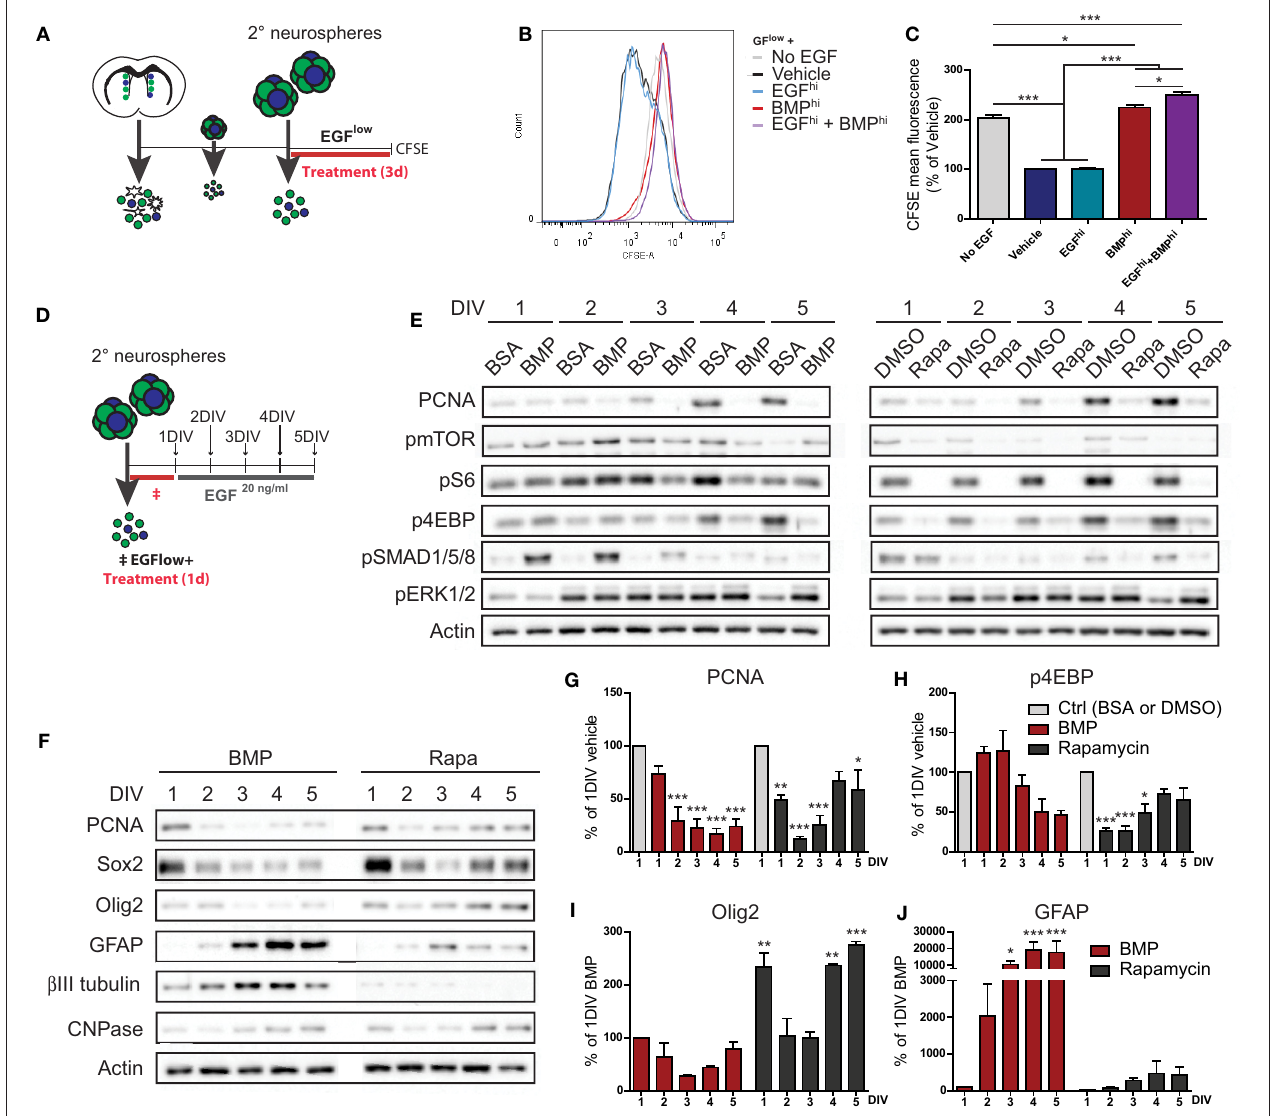
FIGURE 3 | Similarities and differences between BMP treatment and EGF withdrawal-induced suppression of TAP proliferation. (A–C) Effect of EGF and BMP on proliferation kinetics. Experimental paradigm for CFSE experiment (see Materials and Methods for details) (A) . CFSE fluorescence intensity curves (representative example from 1 of 3 experiments) (B) , with mean fluorescence (C) . Note that BMP completely suppresses EGF-induced dilution of CFSE, a measure of the number of cell divisions, and is identical to EGF withdrawal. (D–J) Proliferation recovery assay following transient treatment with BMP or Rapamycin. Experimental paradigm (see Materials and Methods for details) (D) . Western blot analysis for proliferation (PCNA), mTORC1 pathway activation (pmTOR, pS6, p4EBP), SMAD pathway activation (pSMAD1/5/8), ERK pathway activation (pERK1/2), and actin loading control (E) . Representative example from 1 of 3 experiments. (F–J) Western blot analysis for PCNA, TAP (Sox2, Olig2), and differentiation (GFAP, ßIII-tubulin, CNPase) markers (representative example from 1 of 3 experiments) (F) . Densitometry quantifications (G–J) . Note BMP and Rapamycin both suppress proliferation, but BMP additionally stimulates differentiation and does not require a decrease in mTOR pathway activation. * p < 0.05 , ** p < 0.01 , *** p < 0.001 , One-Way ANOVA (Tukey post-hoc test in (C) , Dunnett’s post-hoc test in (G–J) . Data are represented as mean ±